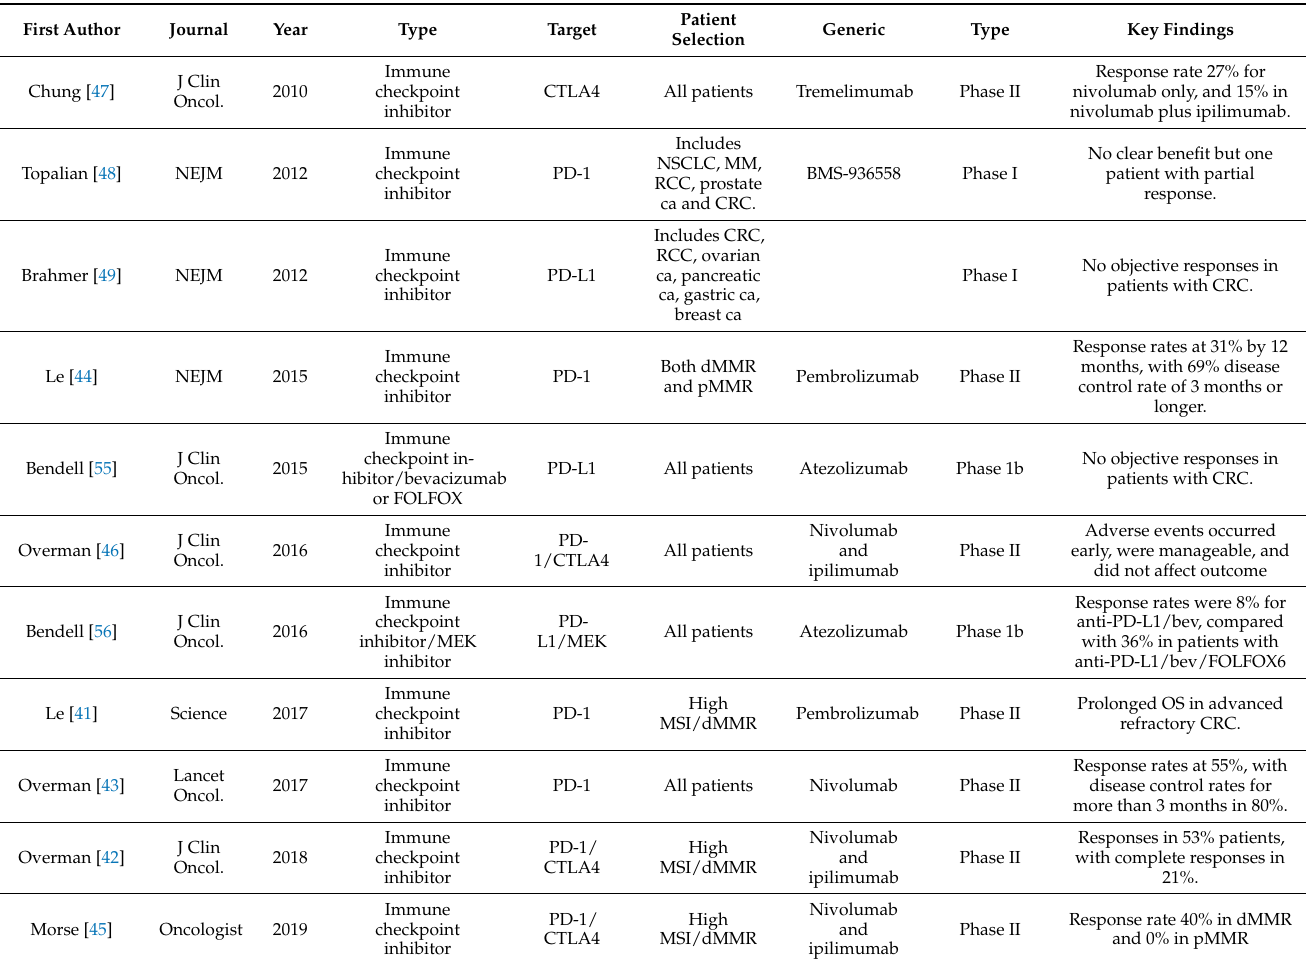
Table 2. Prospective studies of immune checkpoint inhibitors in metastatic colorectal